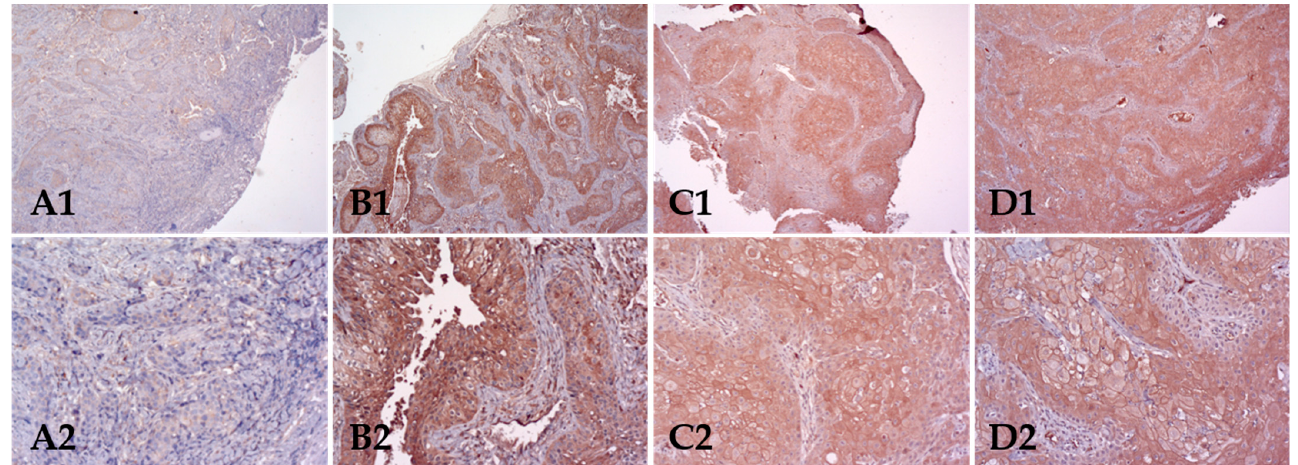
Figure 2. Immunohistochemical staining of the p-S6 in four cases of OSCC already observed in Figure 1, showing now low expression (extent and intensity) ( A ) and high expression (extent and intensity) of p-S6 ( B – D ). Numbers 1 and 2 correspond to magnification of 10× and 20×, respectively.